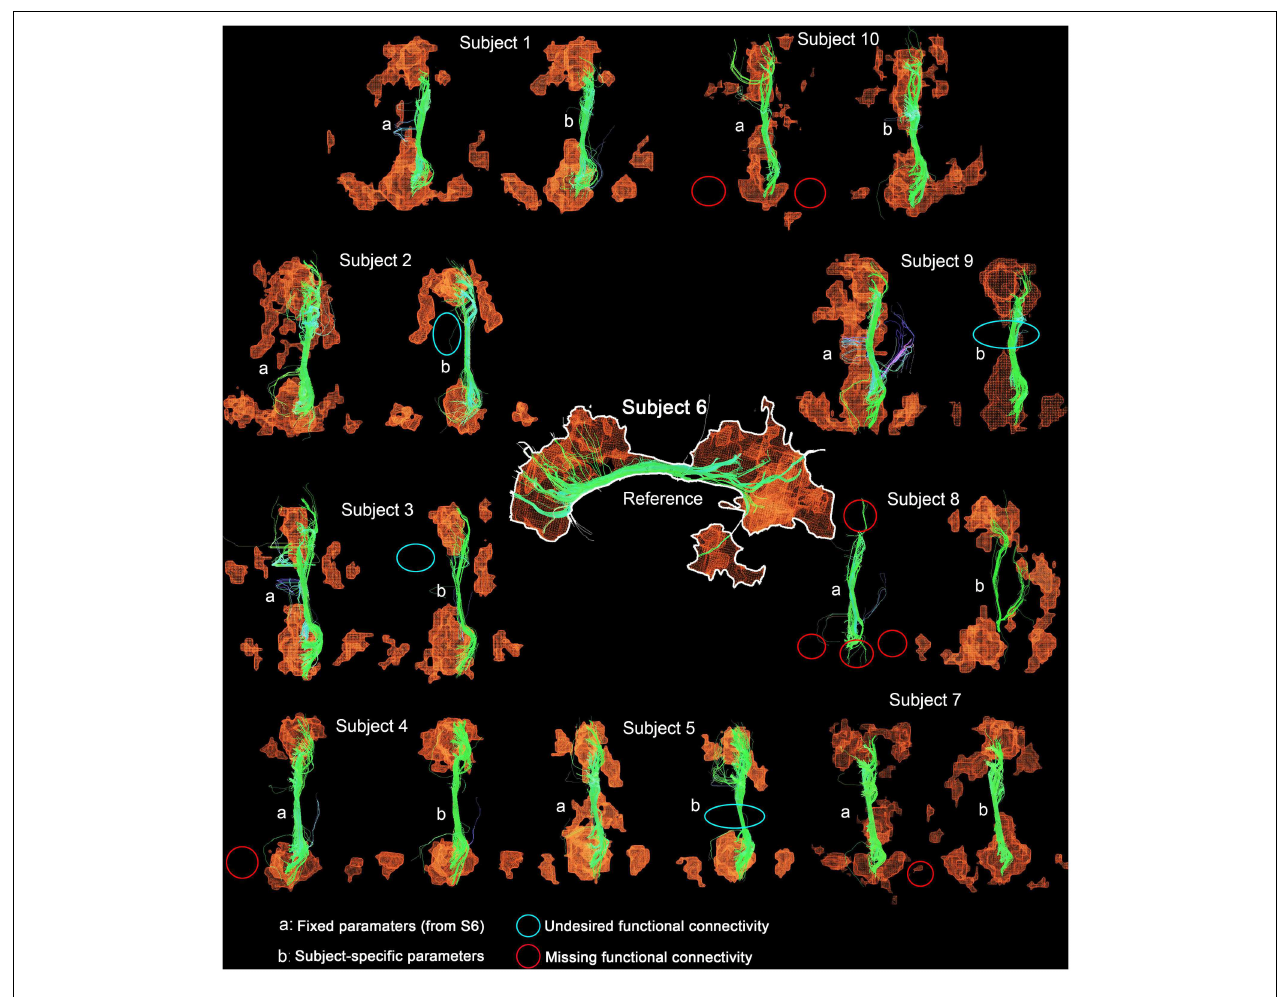
FIGURE 5 | DMN and Cg (right) displayed for all subjects. Middle figure shows the network obtained from reference subject (S6) using parameters in Table 4 . Applying these parameters to all other subjects yielded networks with annotation (A) . Interactively tuning subject-specific